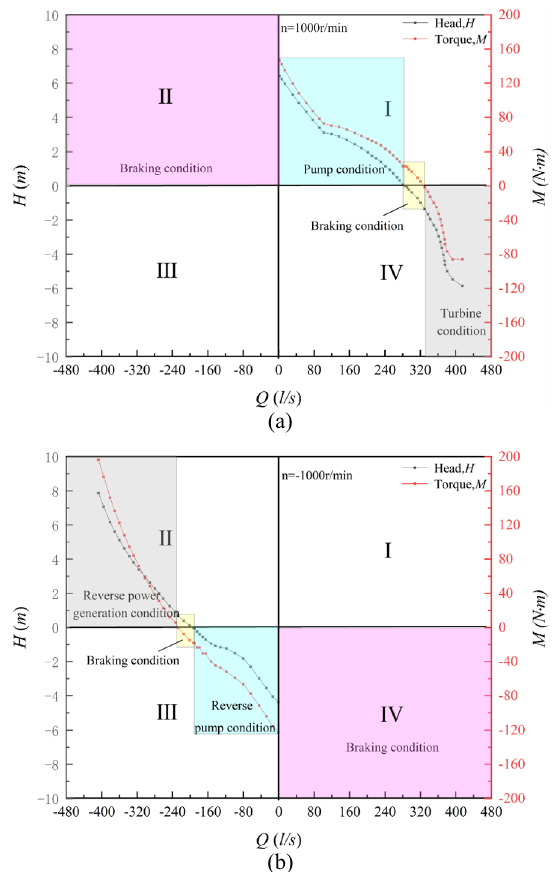
Figure 7. Four quadrant performance curves obtained from the axial flow pump system experiment.